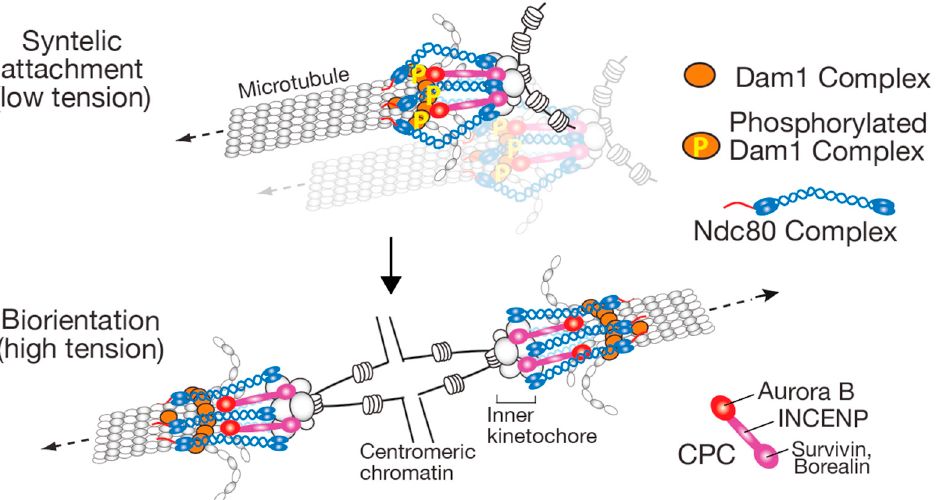
Figure 4. Diagram represents Aurora B spatial separation model, which explains how tension, applied across sister kinetochores, stabilizes kinetochore–MT interactions [4]. CPC is recruited to the inner kinetochore and centromeric nucleosome. During syntelic attachment (aberrant kinetochore–MT interactions), Aurora B reaches Dam1C and phosphorylates its components, which weakens and disrupts kinetochore attachment to the MT end ( top ). When biorientation is established, Ndc80Cs are stretched and Aurora B cannot reach Dam1C, whose dephosphorylation stabilizes kinetochore–MT interactions ( bottom ). Although CPCs are shown only at the inner kinetochore in the diagram for simplicity, CPCs at the centromeric nucleosome (not shown here) also show similar behaviors. The figure was taken from [17] after modification. The CPC consists of Aurora B, INCENP, Survivin, and Borealin, which are called Ipl1, Sli15, Bir1, and Nbl1, respectively, in budding yeast [42].